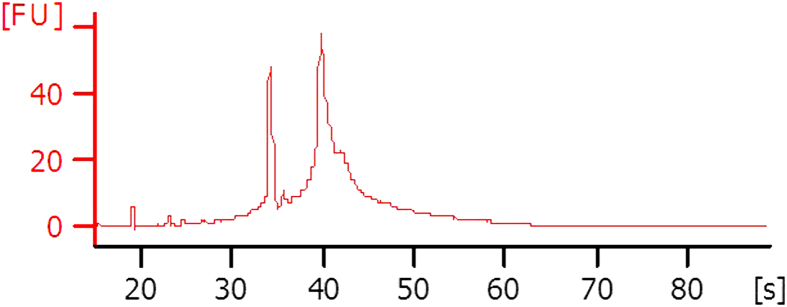
Bioanalyzer analysis of total RNA integrity.Representative electropherogram of Bioanalyzer analysis of total RNA integrity from an individual hindbrain region. Prior to further processing and labelling for microarray hybridisation, all total RNAs were checked on mRNA Pico chips and found to have a RNA Integrity Number (RIN) >7.